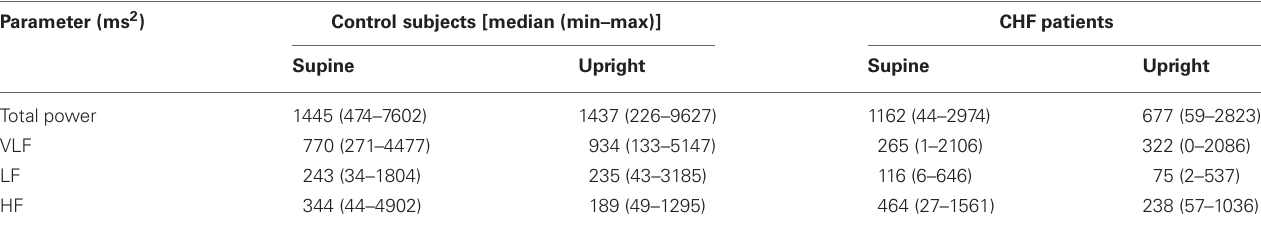
Table 3 | Total power and power in the various bands: VLF, LF, HF; supine values compared to upright. Parameter (ms 2